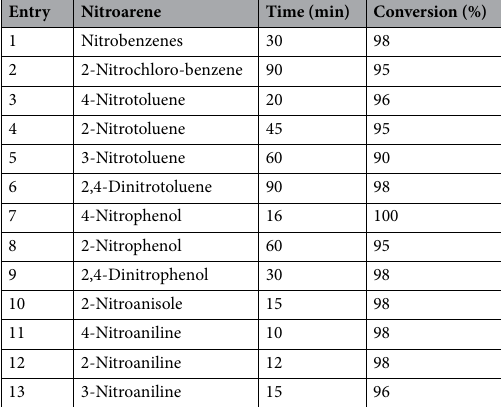
Table 2. Reduction of various nitrobenzenes using GO/Fe 3 O 4 @PDA/Au catalyst. Reaction conditions: 0.3 mL of 0.003 M nitrobenzene, 0.05 mL of 1 mg mL −1 catalyst, and 0.3 mL of 1.2 (M) NaBH 4 solution in